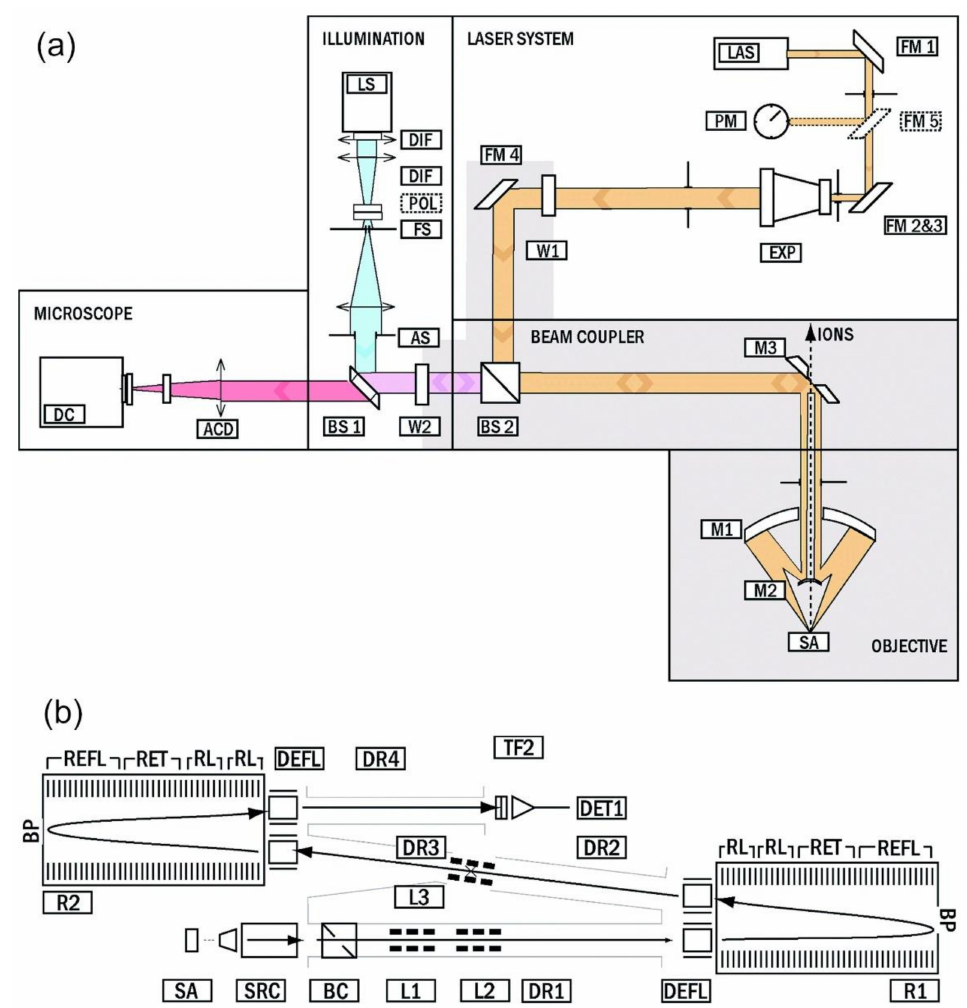
Figure 6. Schematic of optical and ion-optical system of LMS-GT; ( a ) The layout of the optical system applied in LMS-GT combines optics for laser ablation ion source, microscope system and the surface illumination system for the microscope observations. The Schwarzschild objective, supporting tight focusing conditions, is placed near the sample surface; ( b ) Ion optical design of LMS GT: SA: Sample location, SRC: ion source, DR1–DR4: Drift Tubes, L1–L3: Lens 1–3, DEFL: Deflection plates, R1&R2: Reflectrons, RL: Reflectron Lens RET: Retarder Section REF: Reflector Section BP: Backplane, DR: Drift Tubes, DET: Detector (for more details see reference [24]). Reprinted with permission from